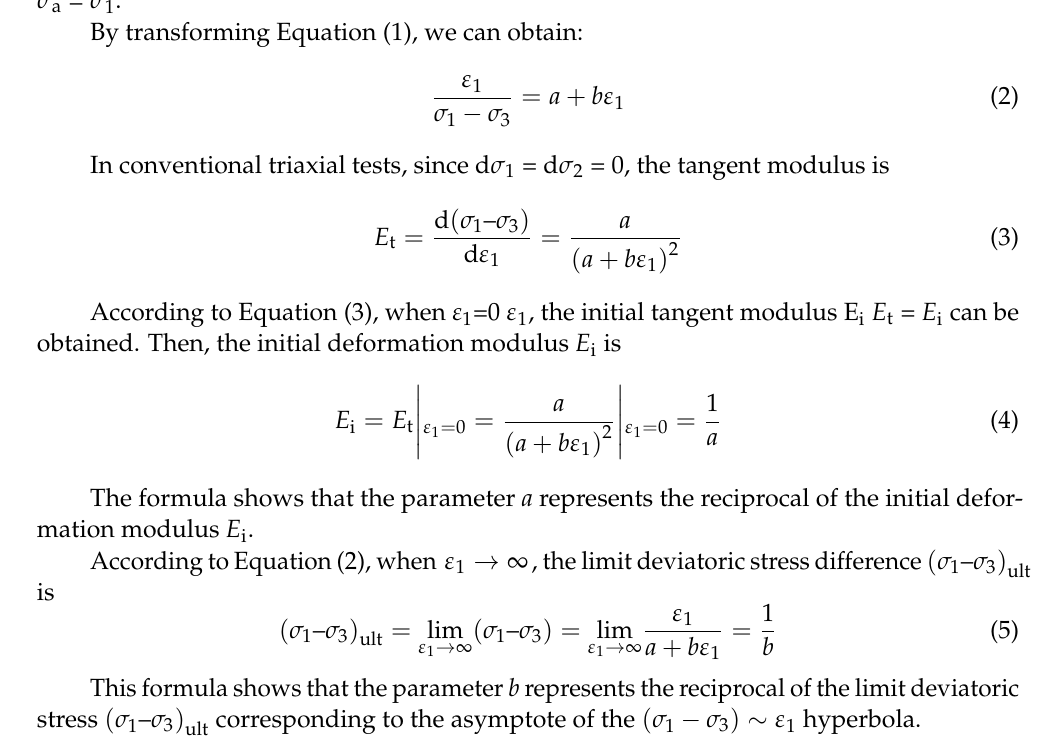
Figure 9. The failure mode of specimen under triaxial test.